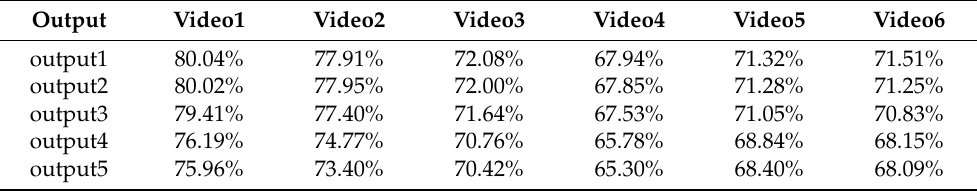
Table 9. The mean IoU values of ‘output1 (cid:48) to ‘output5 (cid:48) for rough detection